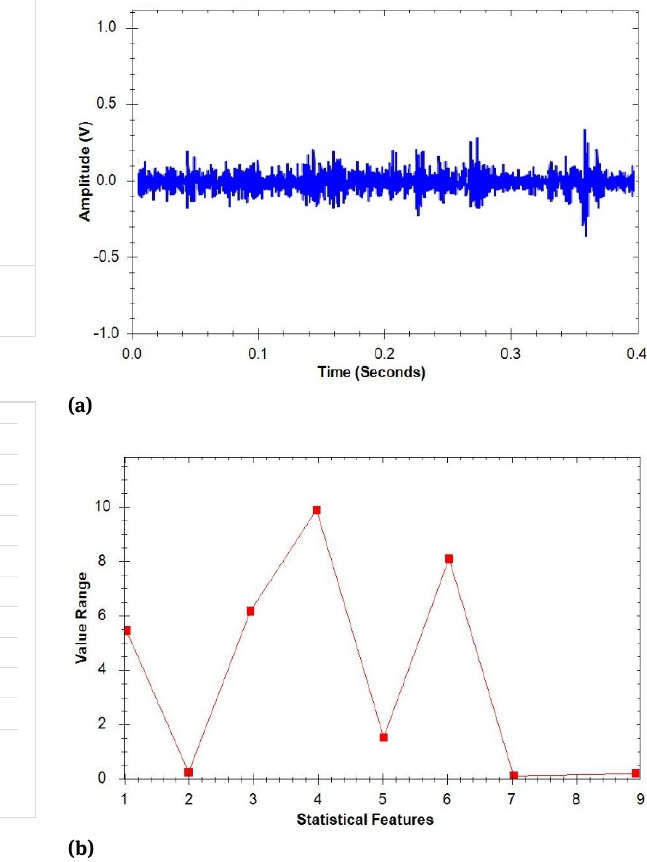
Figure 4: Performance indices; (a, b) performance evaluation of fault diagnosis frequency band at sampling frequency of 10 kHz is 5000 Hz.